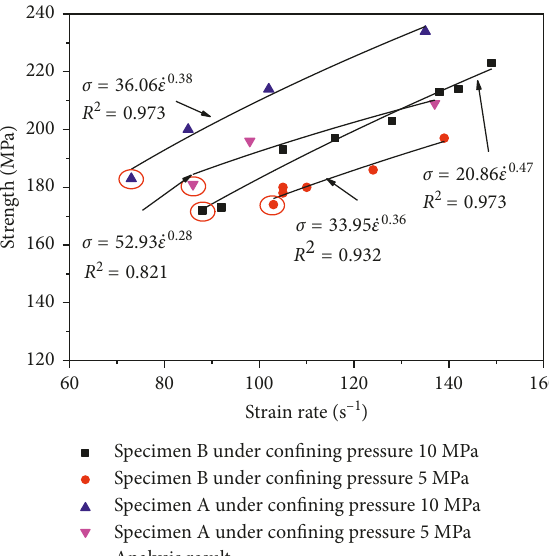
Figure 8: Variation in E 50 with strain rate.